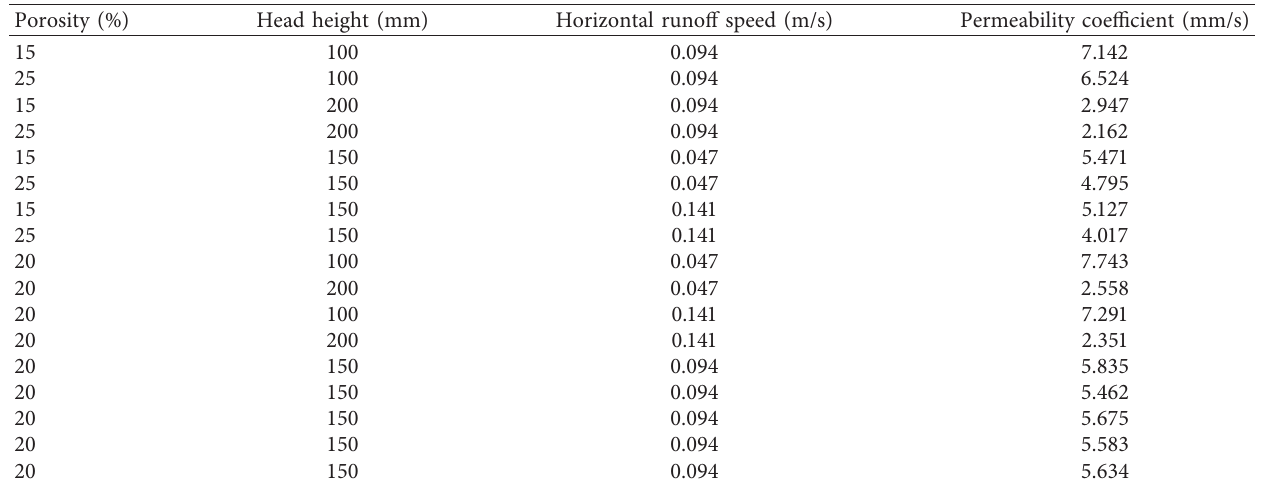
Table 13: Response surface test plan and